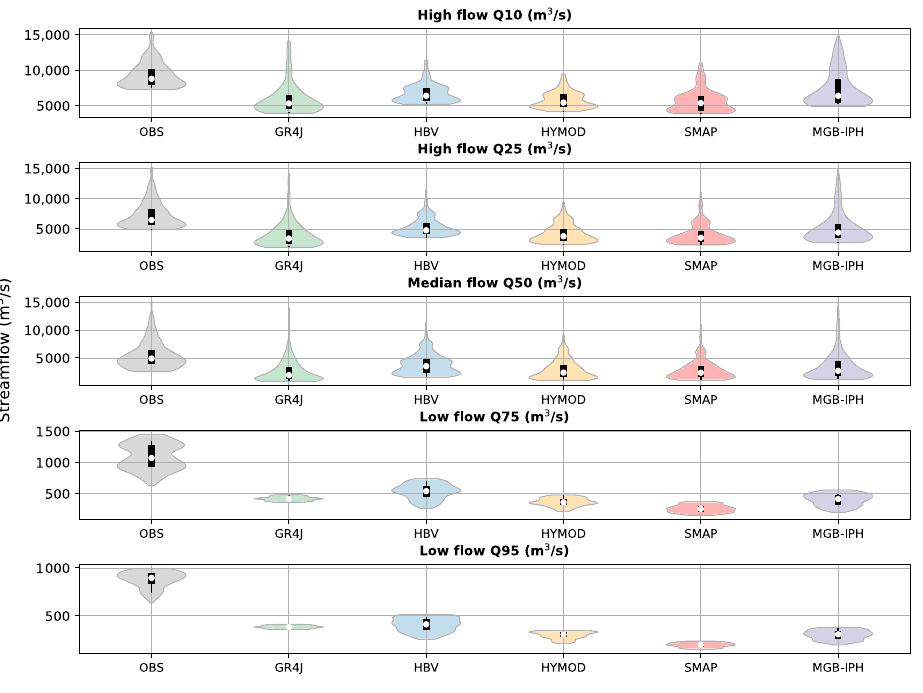
Figure 13. Violin plot describing the low, median, and high flows simulated in the Tocantins river basin by multiple hydrological models. Calibration period.